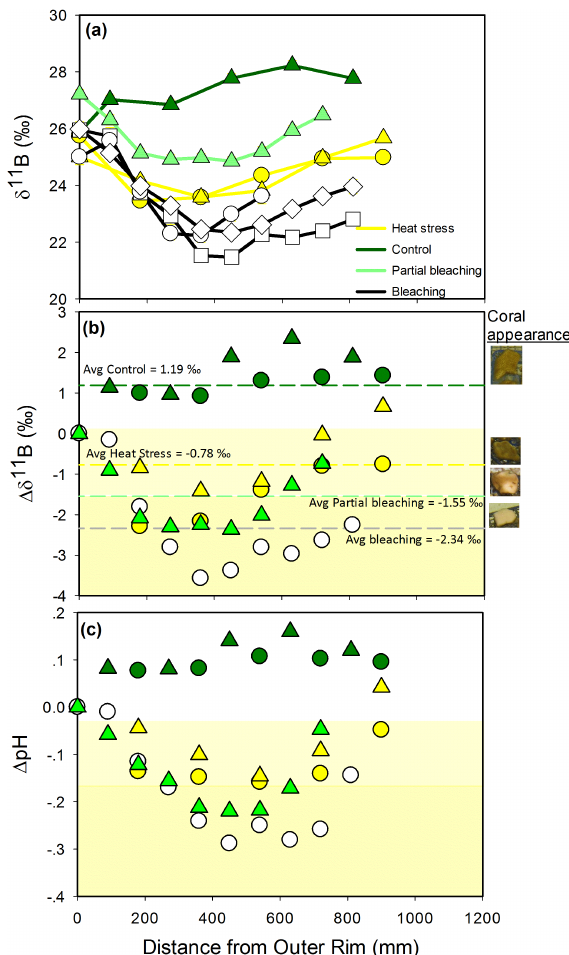
Figure 1. δ 11 B measurements of coral skeletons following dif- ferent bleaching situations. (a) Dark green symbols represent control coral measurements, yellow symbols represent heat- stressed corals, while bright green and white symbols repre- sent partially and fully bleached corals, respectively. Values of δ 11 B = [ 11 B/ 10 B] sample / [ 11 B / 10 B] NIST 610 standard − 1 × 1000. Values are given in parts permil (‰) standard error is within the size of symbols ( ≤ 0.30‰, 2 σ) . Dark and bright green triangles, white diamonds and yellow triangles data series were subtracted with − 2‰ to compensate for a change in instrumental setup (de- tailed in SOM). (b) Relative change from outer rim value for each sample ( (cid:49)δ 11 B). All rim values (at 0µm) were equaled to zero and the change in δ 11 B values was plotted for each transect along the growth axis. Positive values equal an enrichment in values while negative values are depleted relative to the rim value. Dashed lines and above written values represent the average (cid:49)δ 11 B for a coral bleaching state. Coral’s appearance during the heated stage of the experiment is illustrated by the nubbins pictures on the right side. (c) Relative pH change from outer rim value for each sample ( (cid:49) pH). pH values are calculated from δ 11 B using temperature cor- rected pK B in order to compensate for the temperature effect on δ 11 B Borate